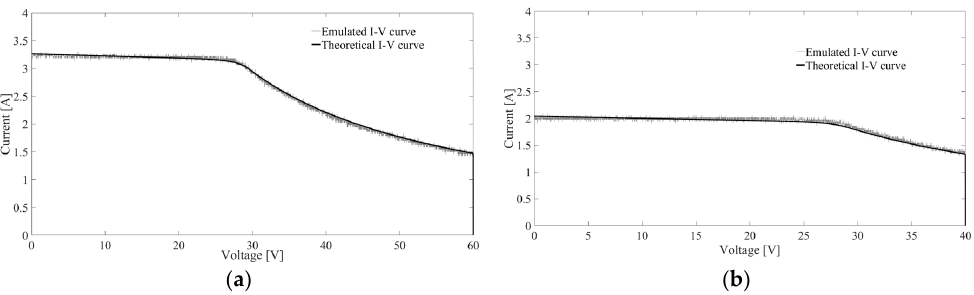
Figure 14. Comparison between emulated (grey curve) and theoretical (black curve) I-V curves: ( a ) S = 400 W / m 2 , T = 57.5 ◦ C and V dsmax = 60 V; ( b ) S = 250 W / m 2 , T = 57.5 ◦ C, and V dsmax = 40 V.